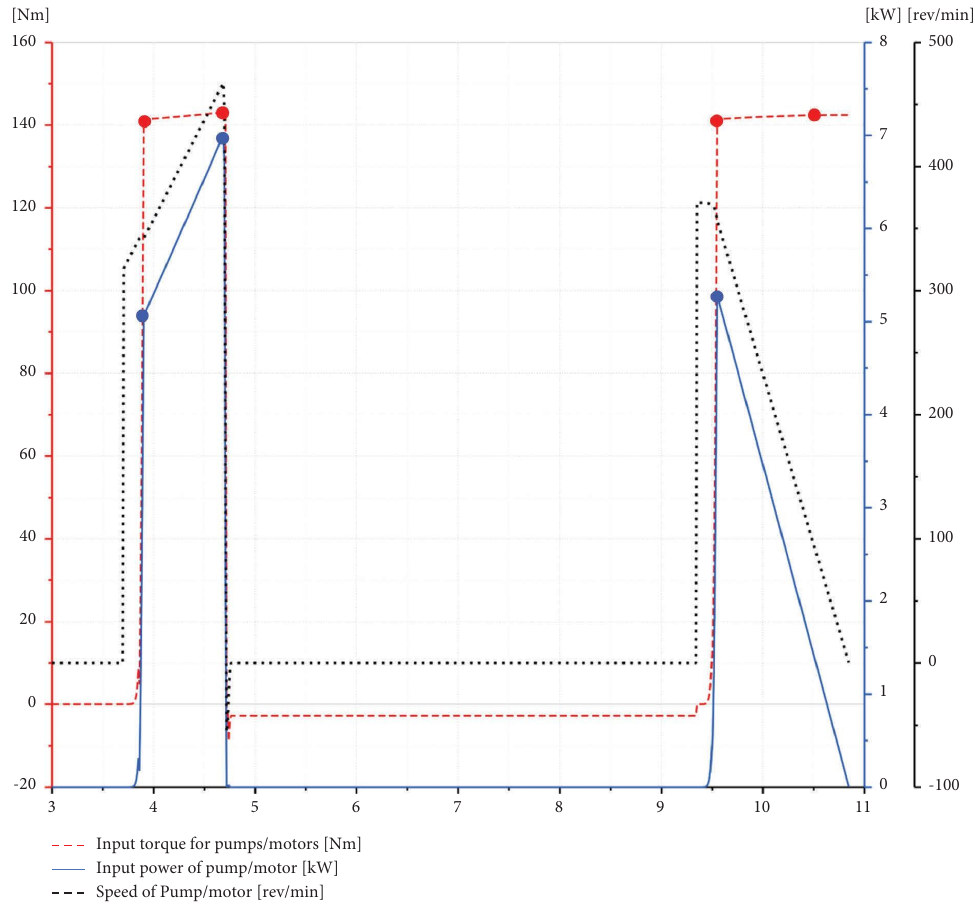
Figure 14: Variations in torque and power in energy recovery systems. Table 7: High-pressure accumulator change in pressure and volume and roll speed